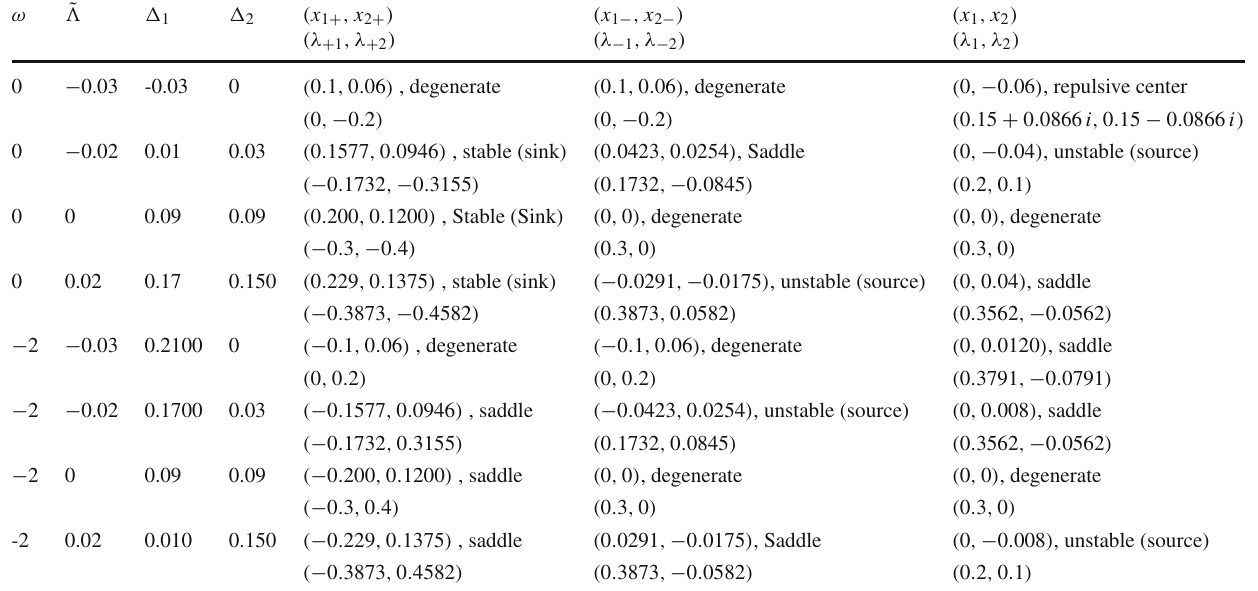
Table2 Resultsfortherepresentativecasesofhavingfixedpointsalong the flat curve solution and also including the possible one along the x 2 axis. The first set are for ω = 0 while the second one for ω = − 2 exhibiting all possible scenarios for the fixed points along the flat curve solution. The quantities ((cid:13) 1 , (cid:13) 2 ) are respectively defined in Eqs. (84)